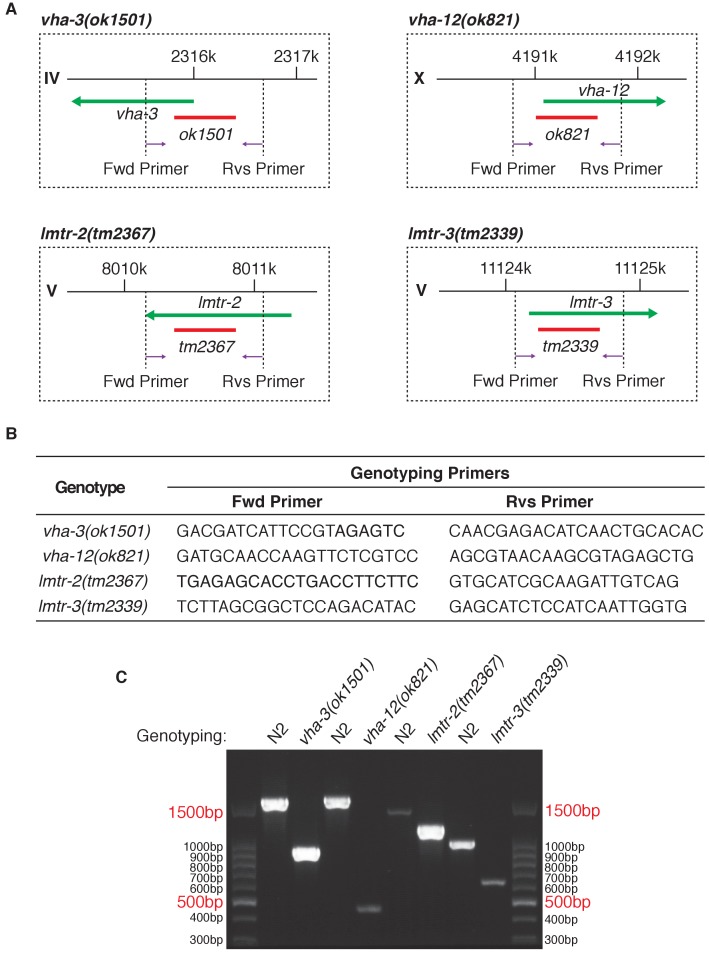
Genotyping of v-ATPase and Ragulator mutants.(A) Schemes depicting deletion and PCR primer positions within each mutant. (B) Primer sequences for genotyping. (C) PCR results of genotyping.